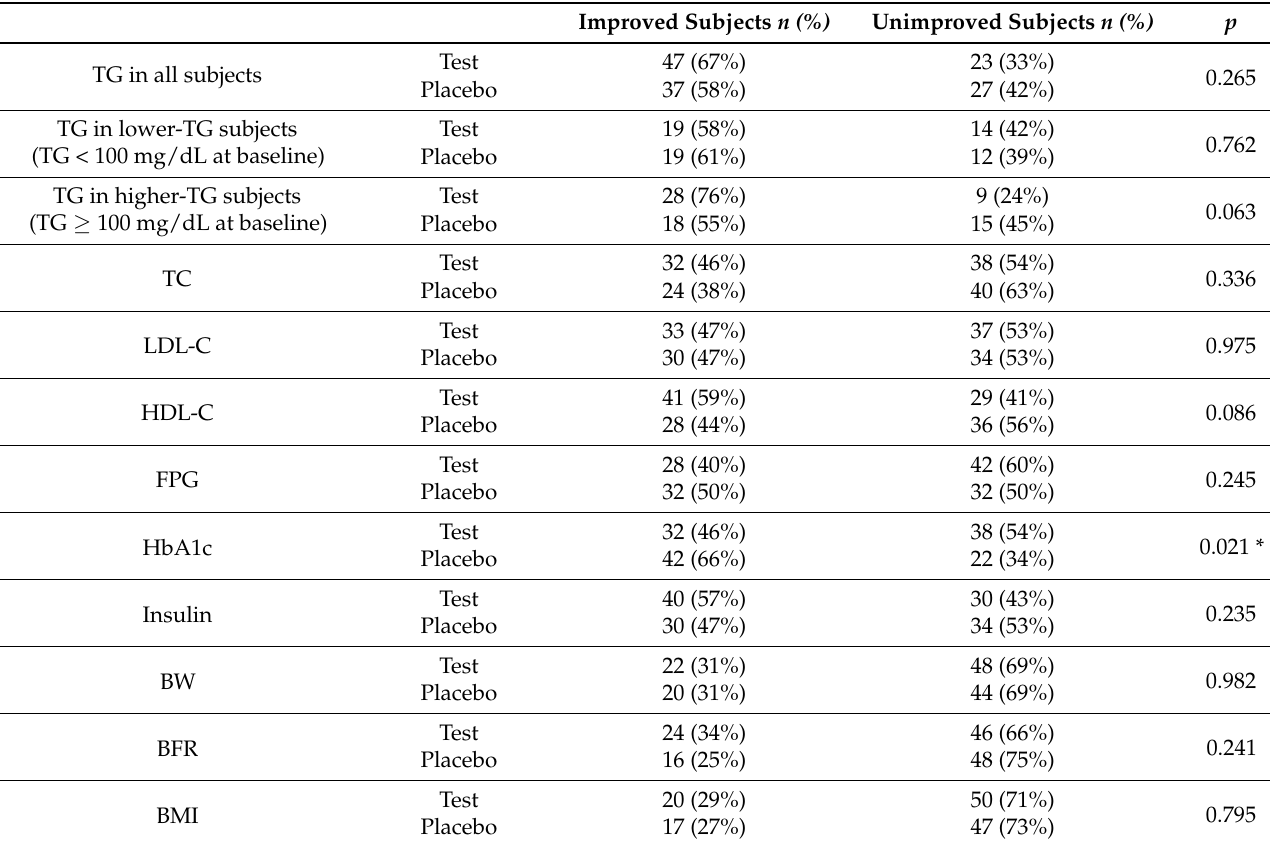
Table 4. Improvement frequencies of lipid metabolism parameters, blood glucose metabolism parameters, and body